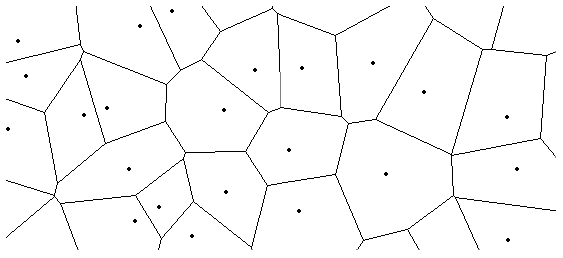
Figure 2. A Simple Voronoi Diagram